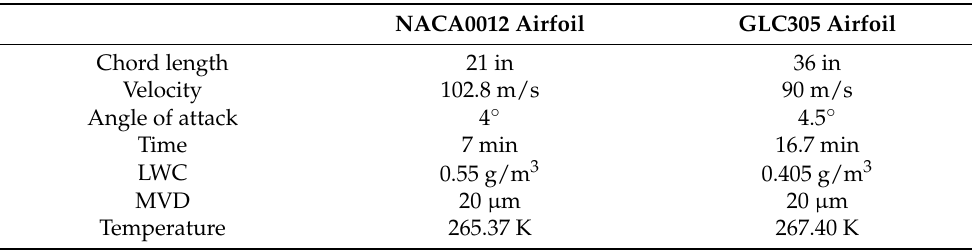
Table 1. Parameters of airfoils used in the numerical